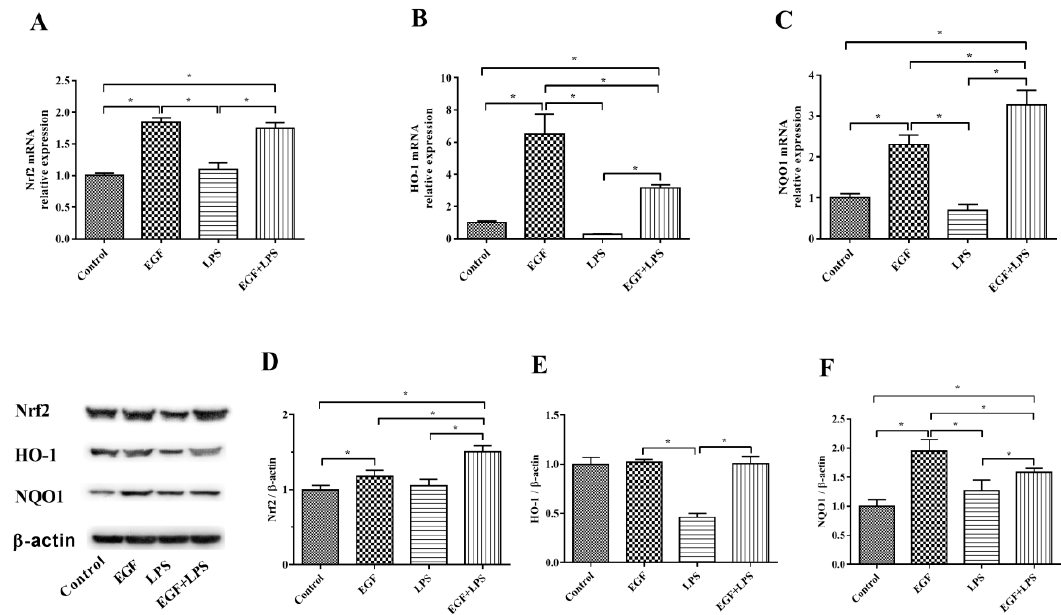
Figure 4. Effects of EGF on Nrf2 signaling pathway-related genes and proteins expression in IPEC-J2 cells challenged by LPS. ( A ) Nrf2 gene expression; ( B ) HO-1 gene expression; ( C ) NQO1 gene expression; ( D ) Nrf2 protein relative abundances; ( E ) HO-1 protein relative abundances; ( F ) NQO1 protein relative abundances. Densitometric values were normalized to β -actin and expressed as a relative level to control values. Data are presented as mean ± SD, n = 3, * p < 0.05.